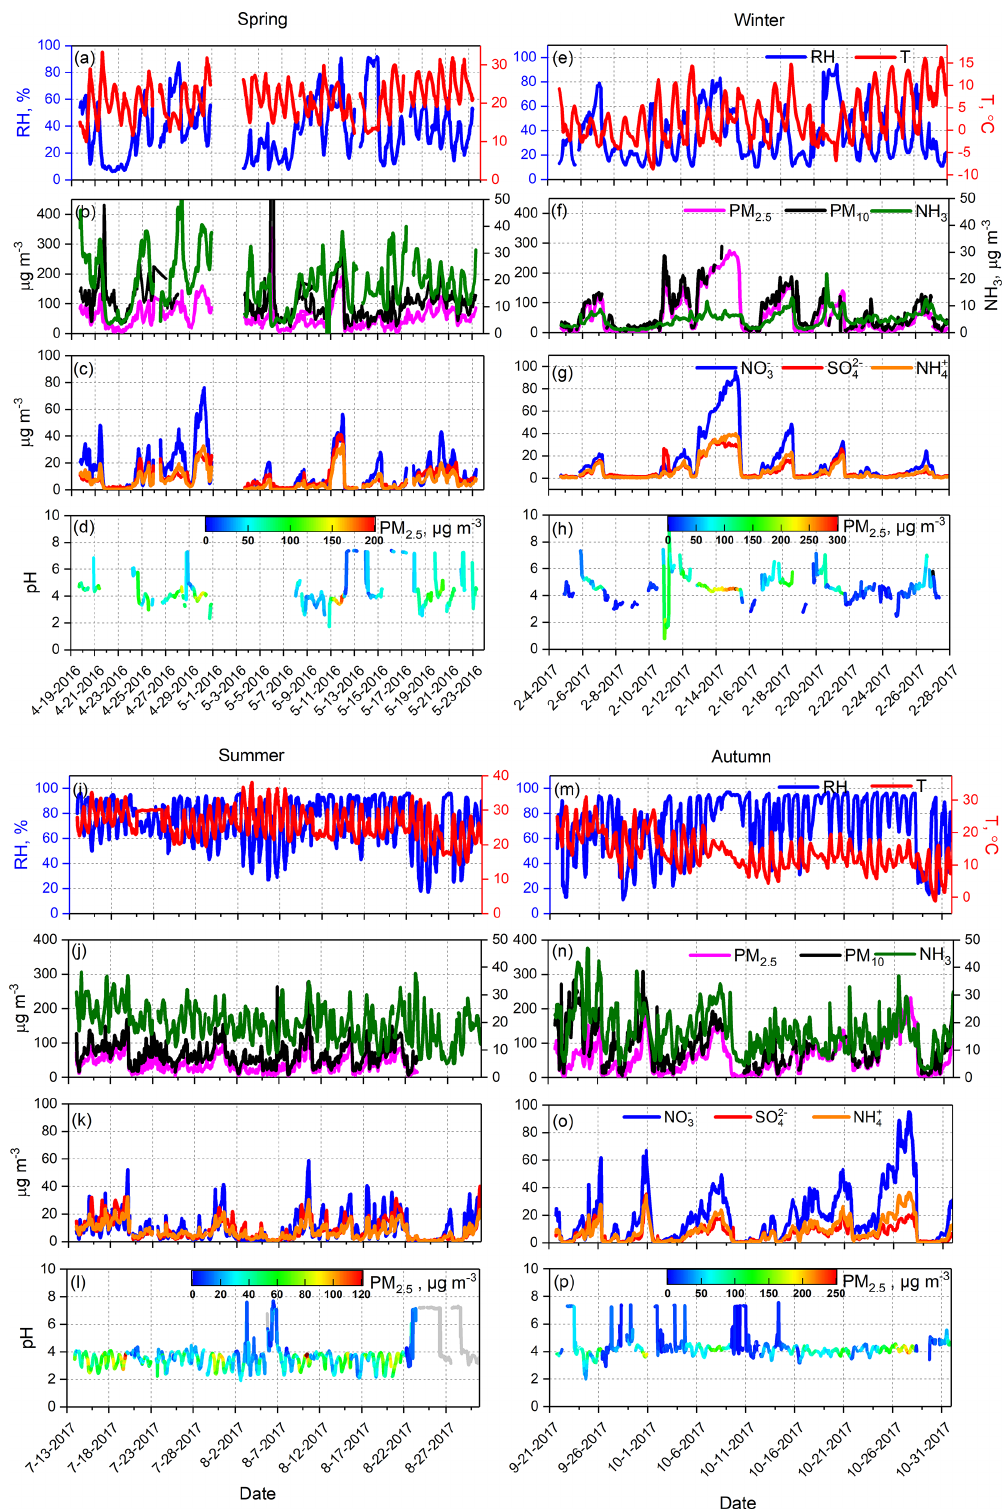
Figure 1. Time series of relative humidity (RH) and temperature ( T ) ( a , e , i , m ); PM 2 . 5 , PM 10 , and NH 3 ( b , f , j , n ); dominant water-soluble ions: NO − , SO 2 , and NH + ( c , g , k , o ); and PM 2 . 5 pH colored by PM 2 . 5 concentration ( d , h , l , p ) over four 3 4 4